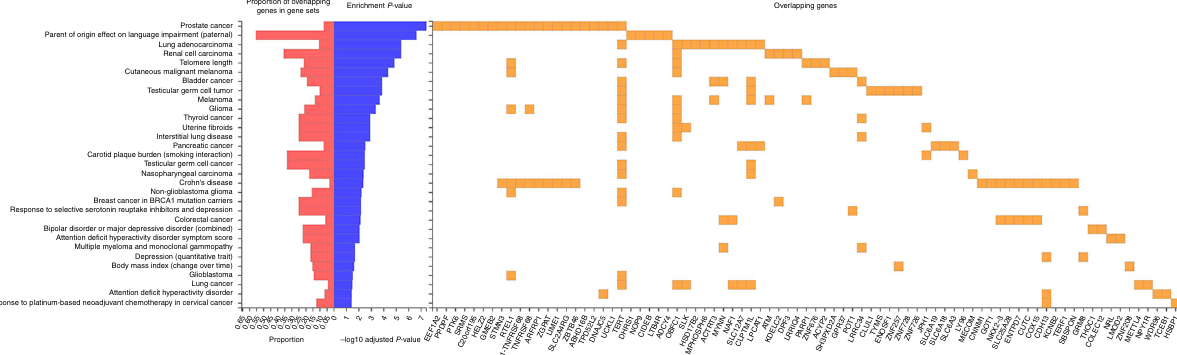
Fig. 5 Gene set enrichment of mapped regional genes for LTL association in previous GWAS studies. Enrichment P -values adjusted for Bonferroni corrections and proportion indicates the percentage of input LTL associated genes that overlap with genes implicated in previous GWAS traits